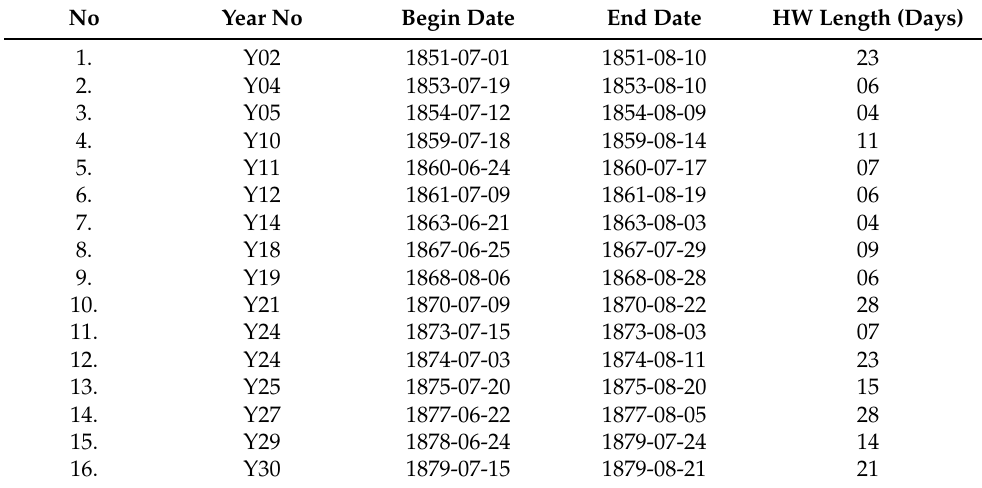
Table 1. An overview of the years, beginning (10 days before HW) and end date (7 days after HW) of the intermittent RRM